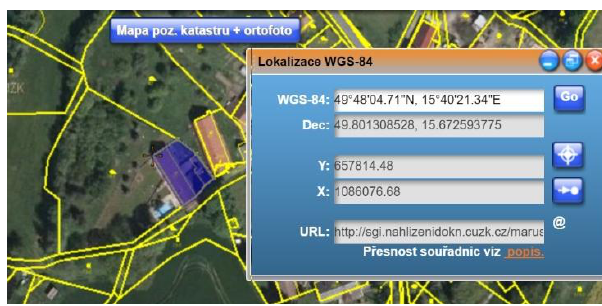
Figure 10b. Reading the coordinates from the estate cadastre in the national coordinate system